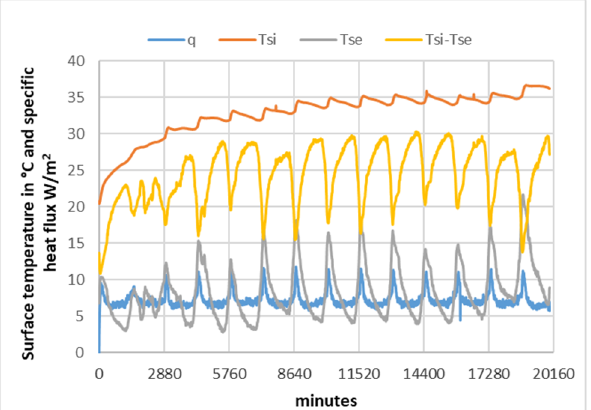
Figure 18. Pre-assembled prototype: heat flux and surface temperatures from February 9 th to 23 rd 2019.